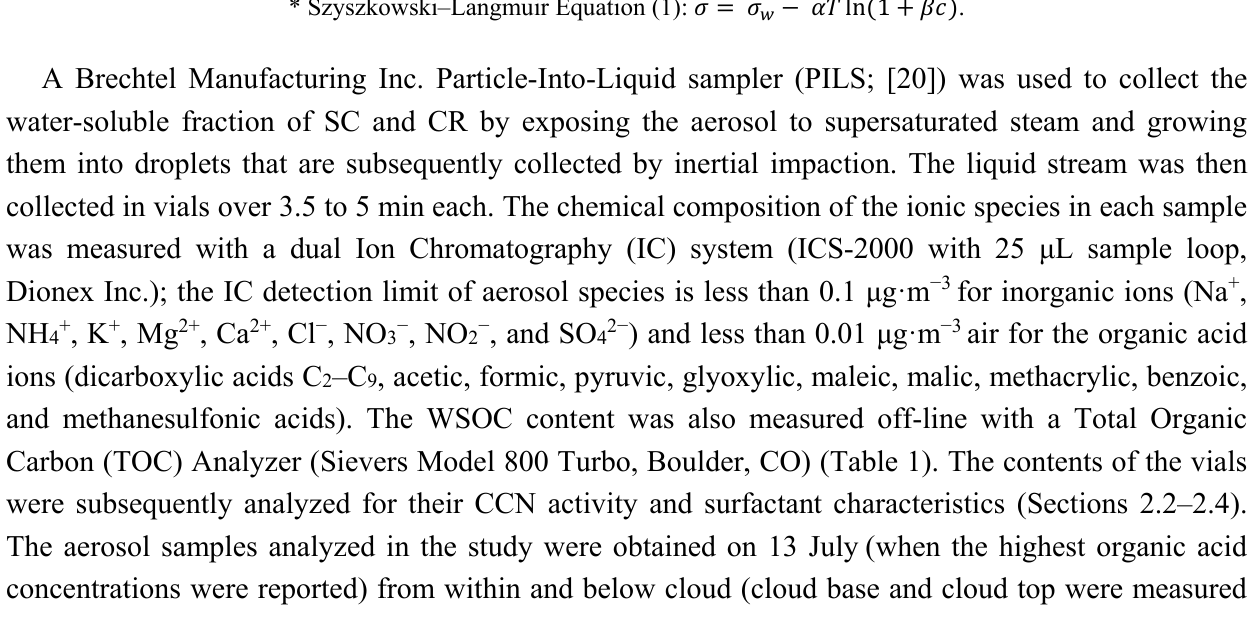
Table 1. Concentrations of Water Soluble Organic Carbon (WSOC) and ions (mg·L − 1